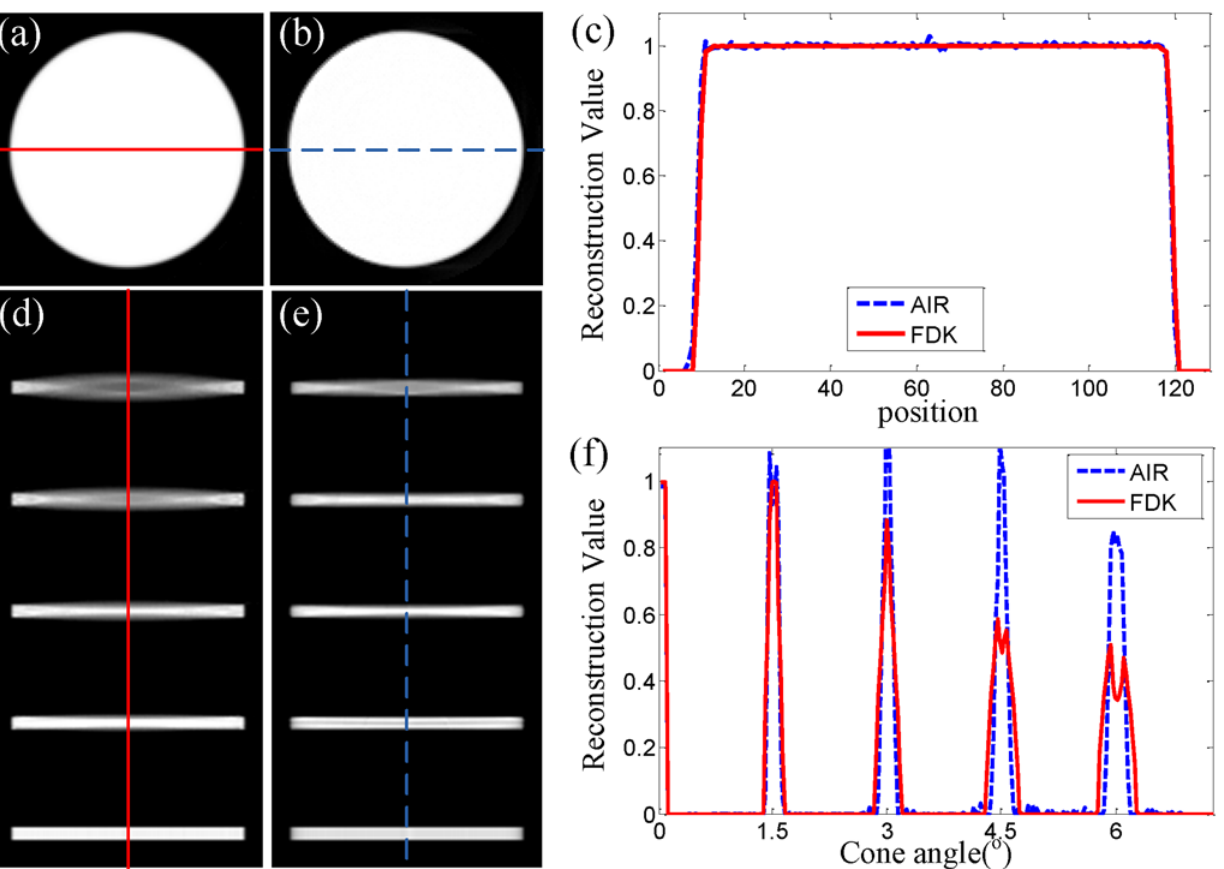
Fig 3. Numerical simulation results. (a) and (b) are the images of the axial mid-plane of the Defrise phantom reconstructed by FDK and AIR algorithms respectively, which correspond to the case with a cone-beam angle of 0 (cid:2) . (d) and (e) are the sagittal slices reconstructed by FDK and AIR algorithms respectively, which have a maximum cone-beam angle of 6 (cid:2) . Starting from the bottom, the central layer of each disc corresponds to a cone angle of 0 (cid:2) , 1.5 (cid:2) , 3.0 (cid:2) , 4.5 (cid:2) and 6.0 (cid:2) . (c) and (f) present the profiles along the red solid lines and the blue dashed lines in (a), (b) and (d), (e). The display grey scale is set to be [0 1.1]×10 − 6 . The relax coefficient is set to be 0.8 and the number of the overall iterations is 10.